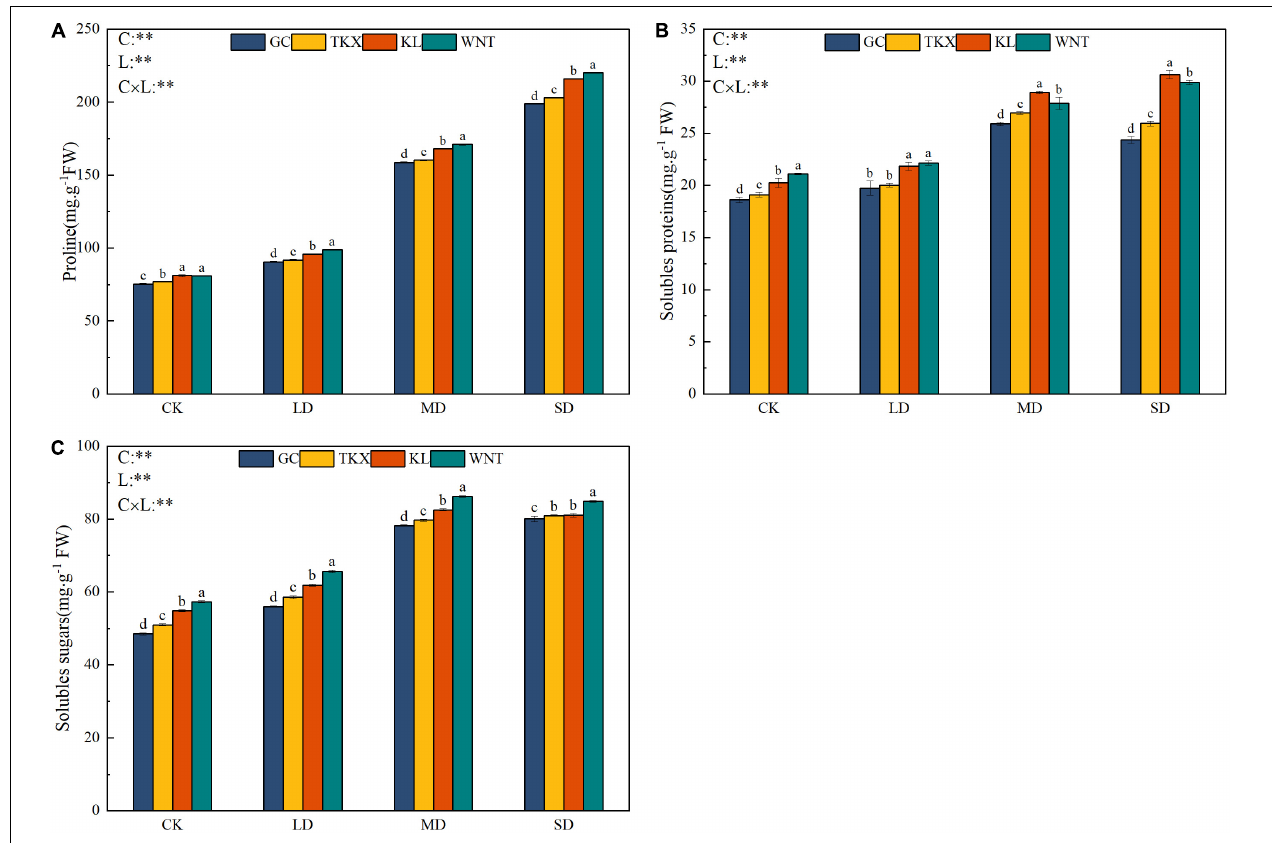
FIGURE 5 | Effects of drought stress on the osmoregulatory substances of different geographical populations Solanum rostratum . Changes in proline (A) , soluble protein (B), and soluble sugar content (C) of S. rostratum under different drought-stress concentrations. The blue column represents the GC site, yellow column represents the TKX site, red column represents to KL site, and green column represents the WNT site. Different lowercase letters indicate a significant difference under drought stress in S. rostratum populations, according to Duncan’s test ( α = 0.05). C refers to the differences among drought-stress concentrations; L refers to the differences among each geographical population; C × L refers to the interaction between populations and concentration. The significant change in functional traits between the four collection sites was shown by the significance of population–stress treatment interactions. Asterisks indicate a significant difference (*, p ≤ 0.05; **, p ≤ 0.01; ***, p ≤ 0.001). Refer to statistics in Supplementary Table 1